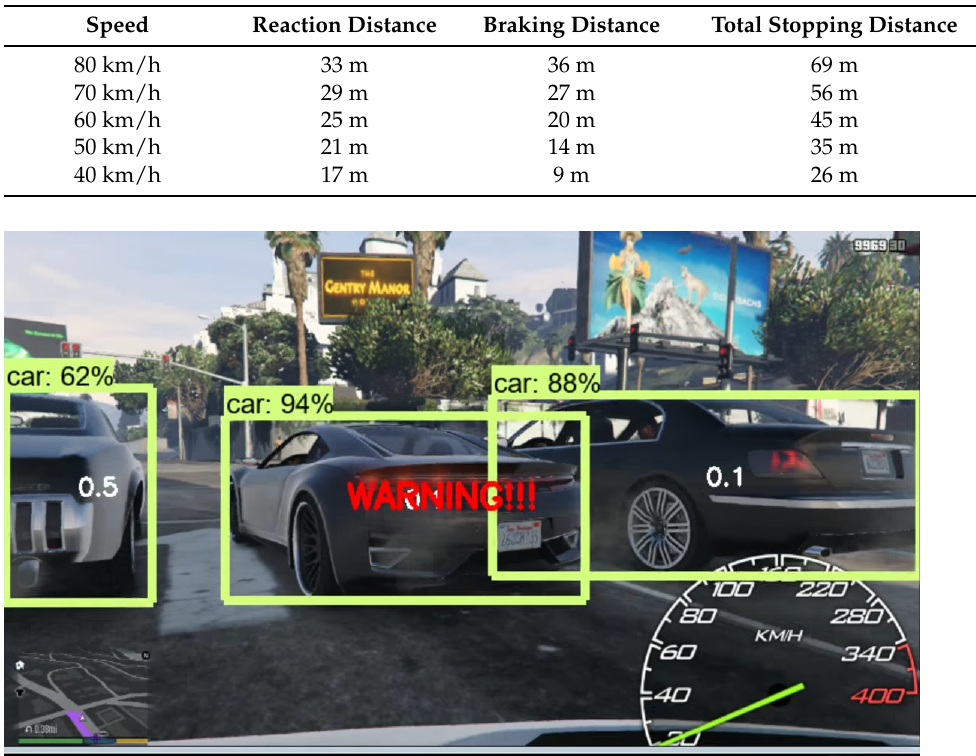
Table 2. Braking distance calculation of dry road.